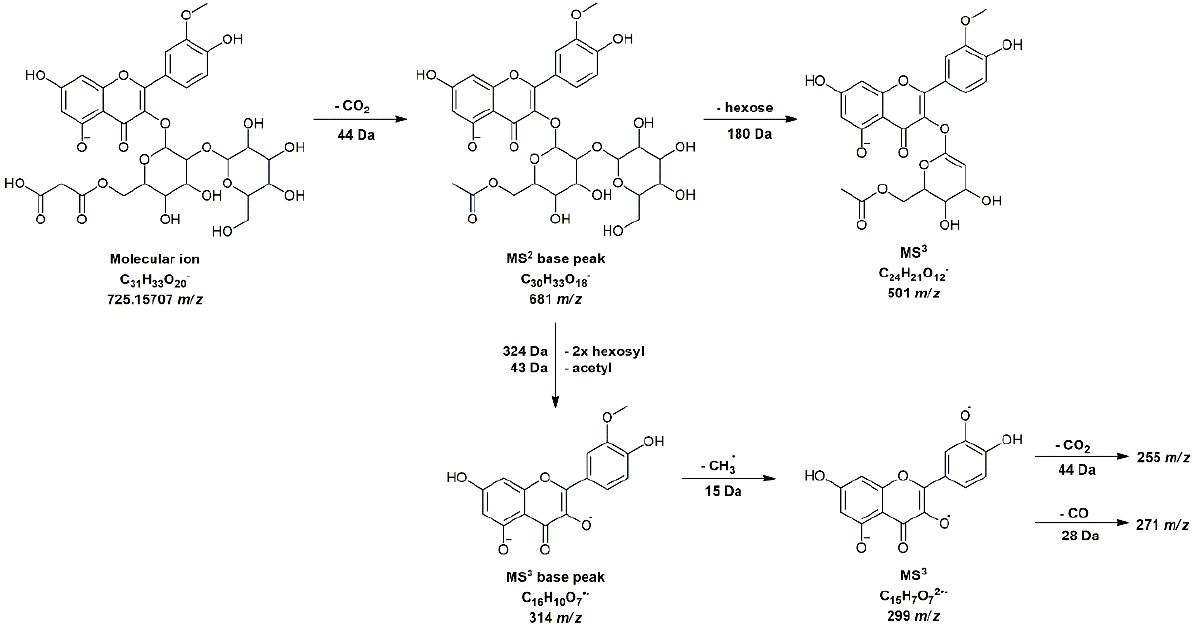
Figure A1. Fragmentation pathway of isorhamnetin 3- O -(2 ″ -hexosyl-6 ″ -malonyl-hexoside (compound 16).